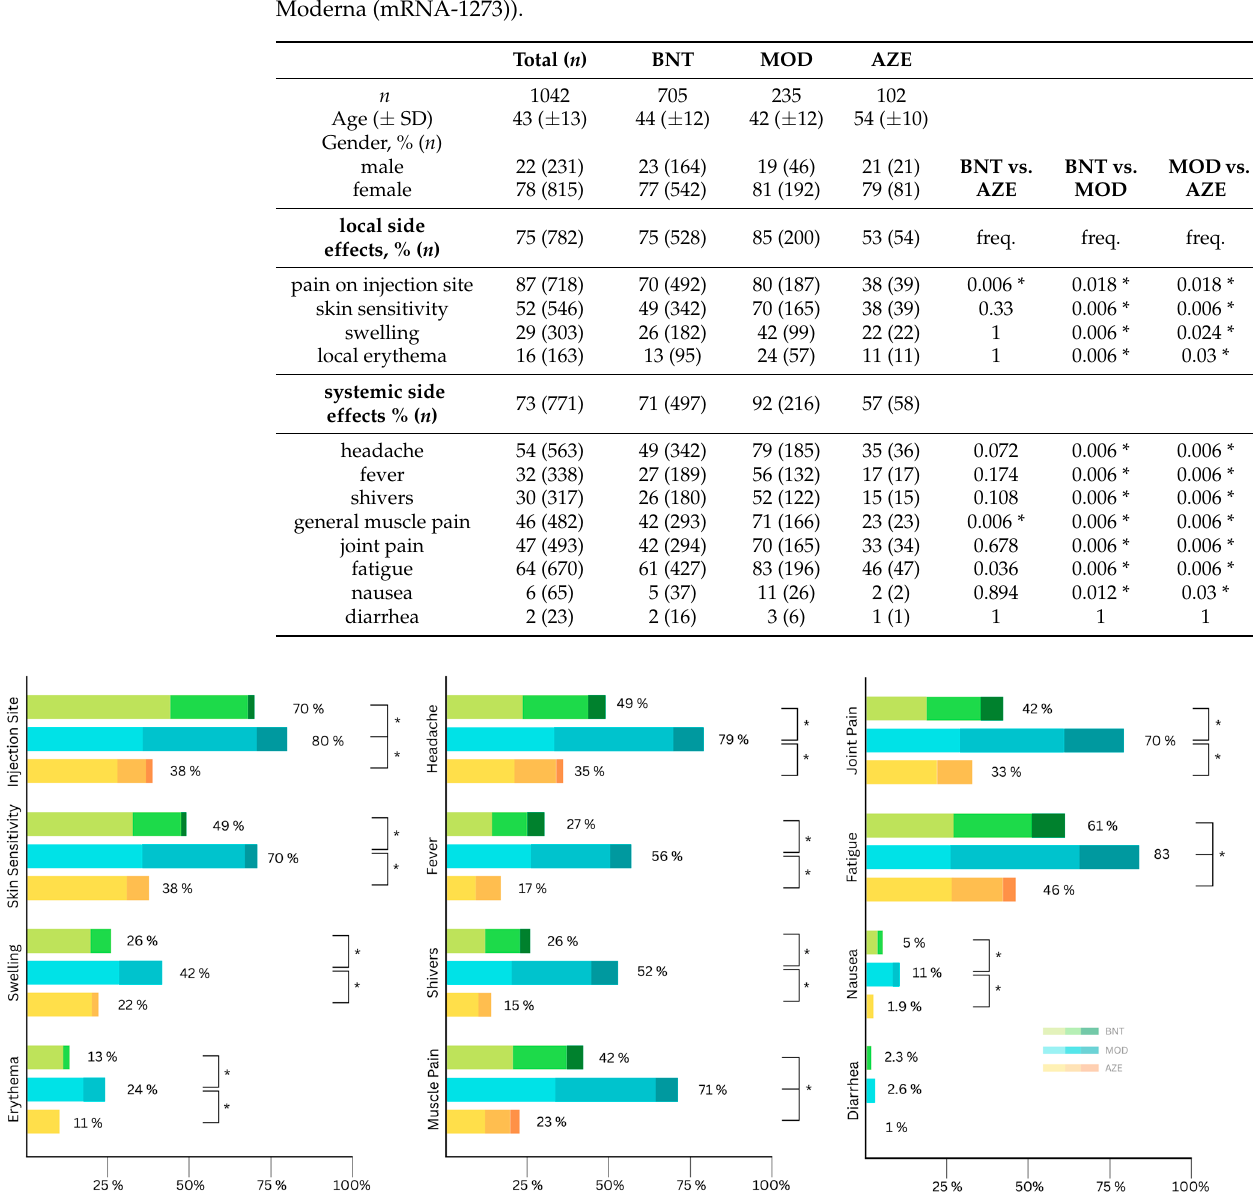
Figure 2. Distribution of self-reported local side effects according to symptom severity (mild, mod- erate, severe) after the second vaccination (AZE: AstraZeneca (ChAdOx1 nCov19); BNT: Bion- tech/Pfizer (BNT162b2); MOD: Moderna (mRNA-1273)). Asterisks indicate significant differences in severity.